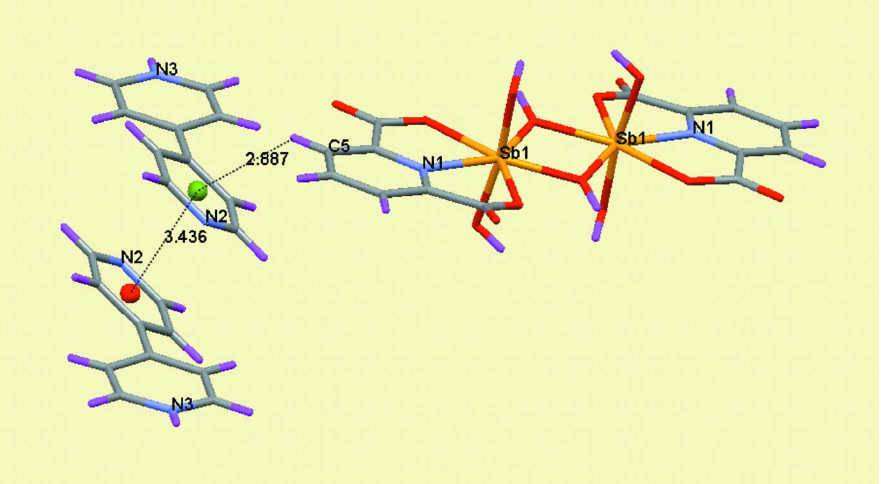
( µ -OH)] } 2- dianions are 2 2